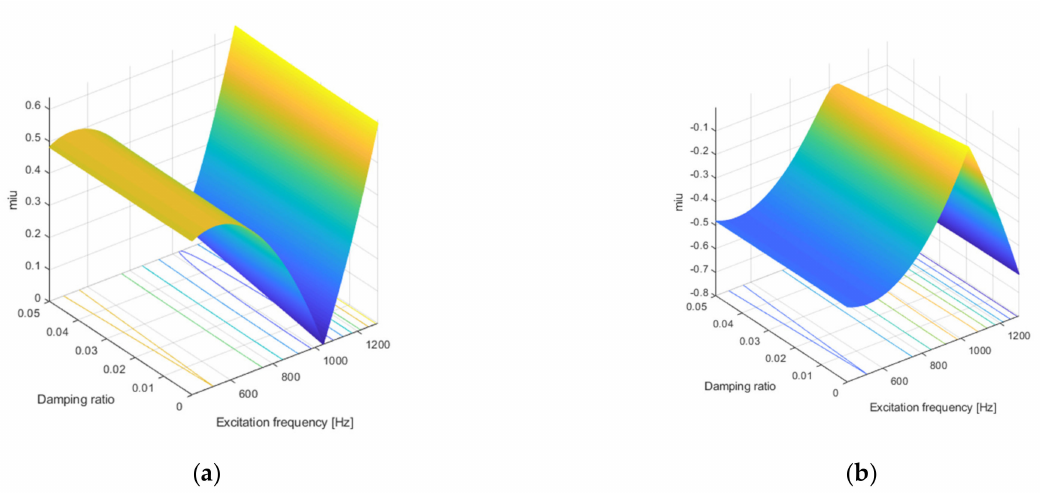
Figure 19. Stationary dynamic instability surface frontier for the tulip. ( a ) µ > 0. ( b ) µ <